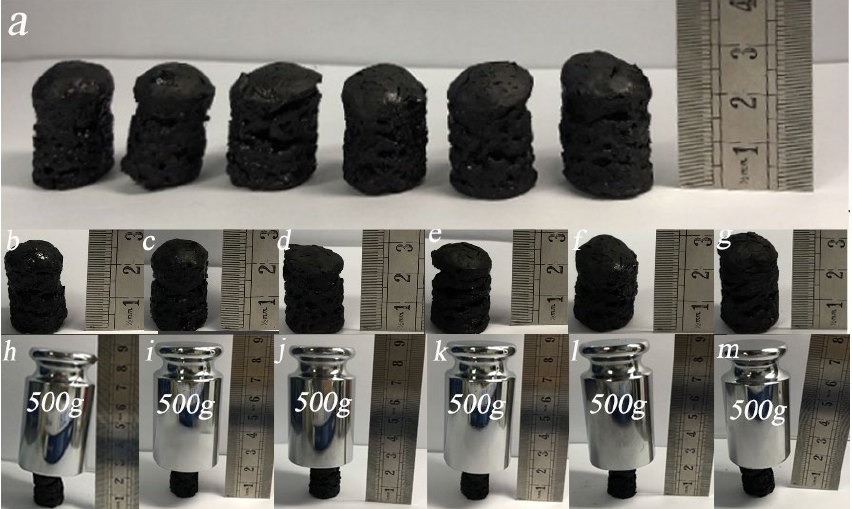
Figure 6. Compression testing of the GA-PEI and GA-MCC-PEI-(1–5) aerogels: ( a ) photograph of all samples, ( b – g ) photographs of individual samples, and ( h – m ) photographs of samples under 500 g pressure.